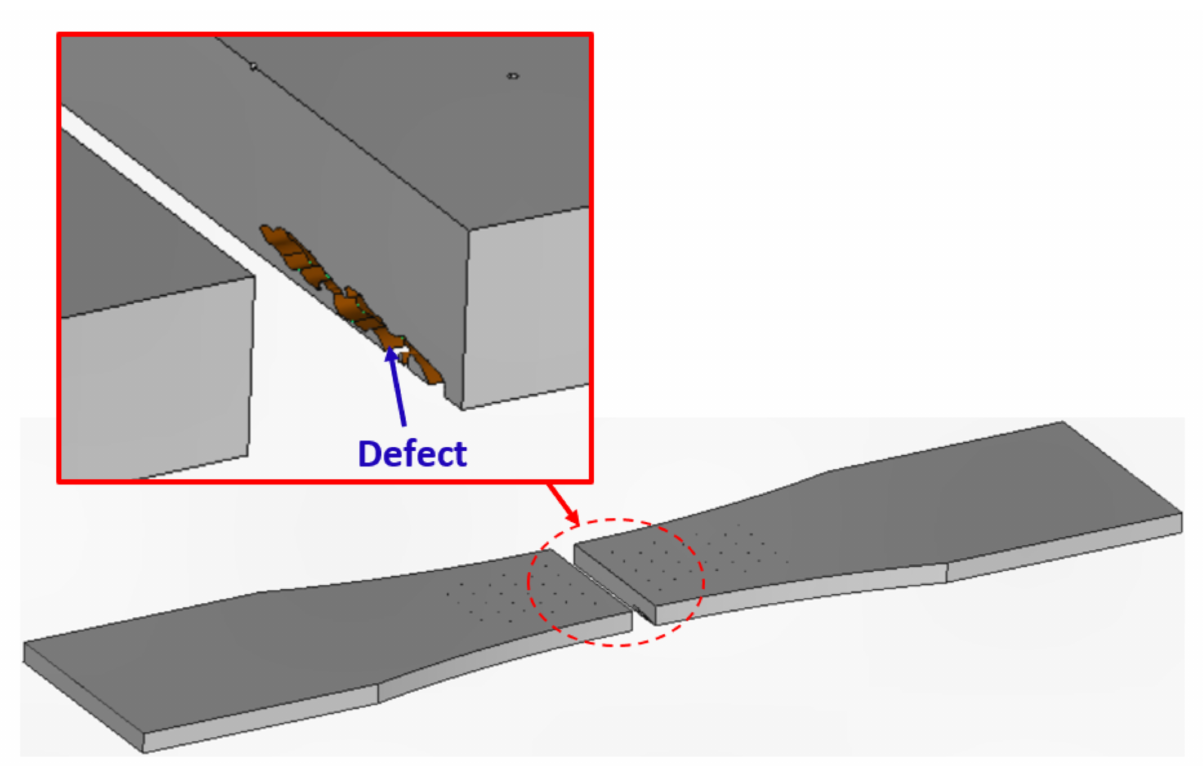
Figure 13. Specimen 2 geometry.